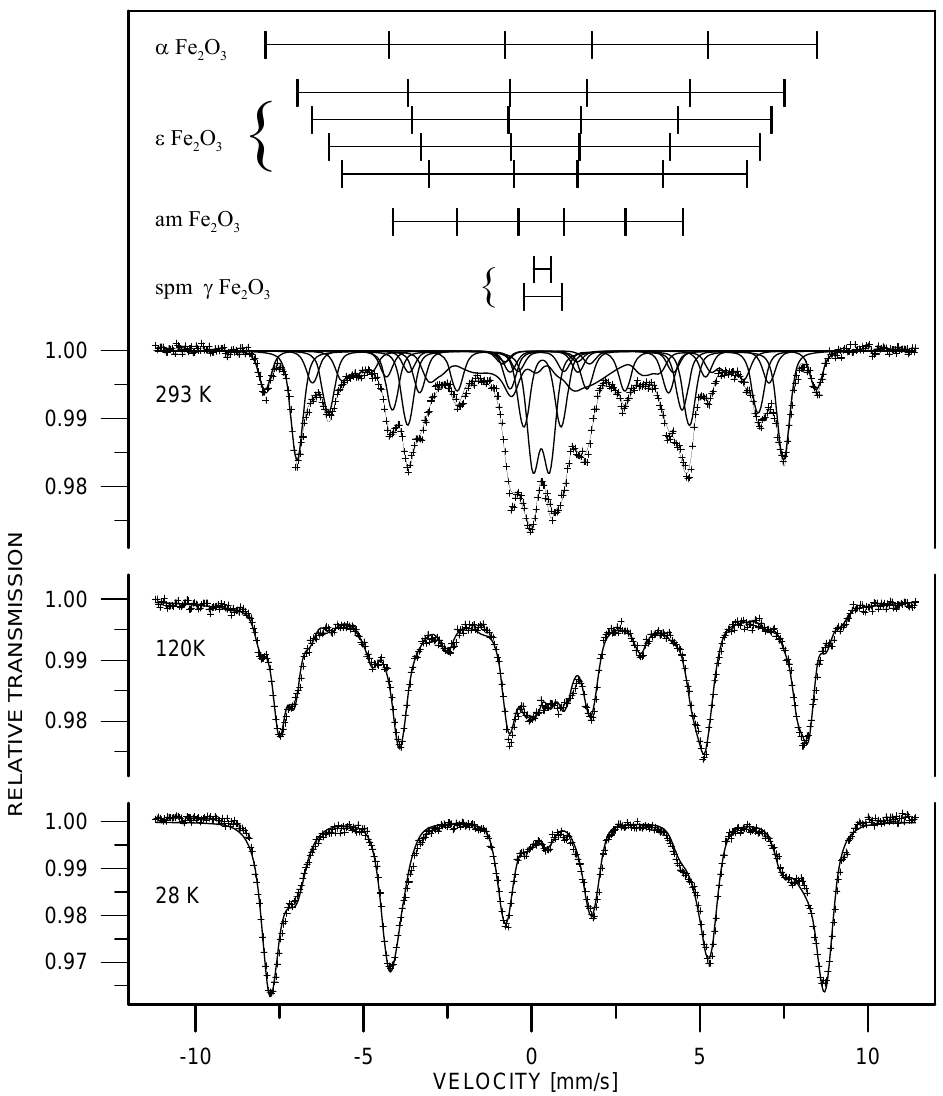
O /SiO sample depending on measurement temperature 2 3 2